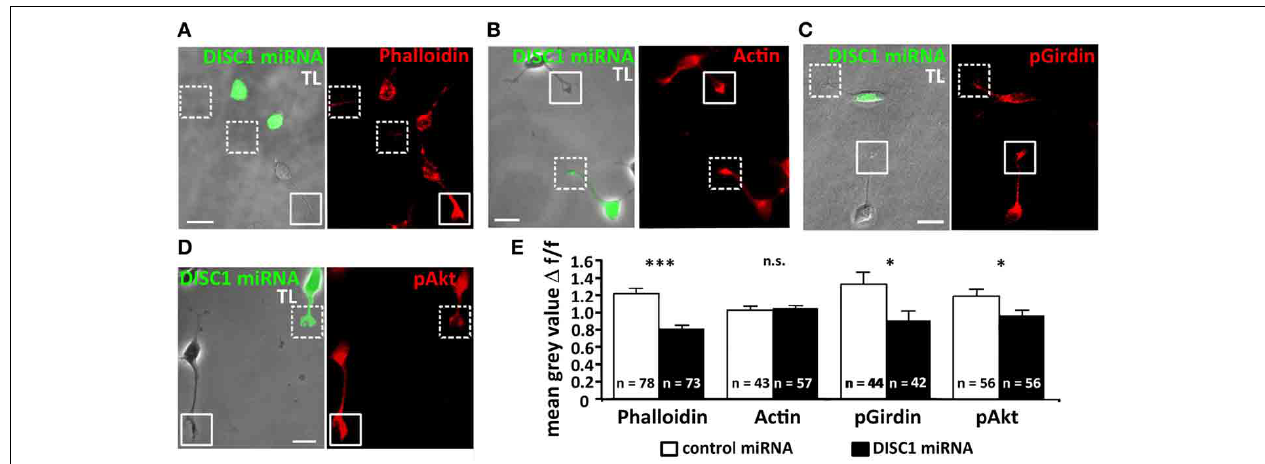
FIGURE 5 | Knockdown of DISC1 affects the actin cytoskeleton in migrating interneurons. (A–D) Fluorescence micrographs of DISC1 miRNA expressing (green) and untransfected cells stained with phalloidin (A) , α -actin (B) , α -pGirdin (C) , and α -pAkt (D) antibodies. Frames display the tips of the leading processes. TL, transmitted light. Scale bars: 10 μ m. (E) Quantification of the fluorescence intensities of